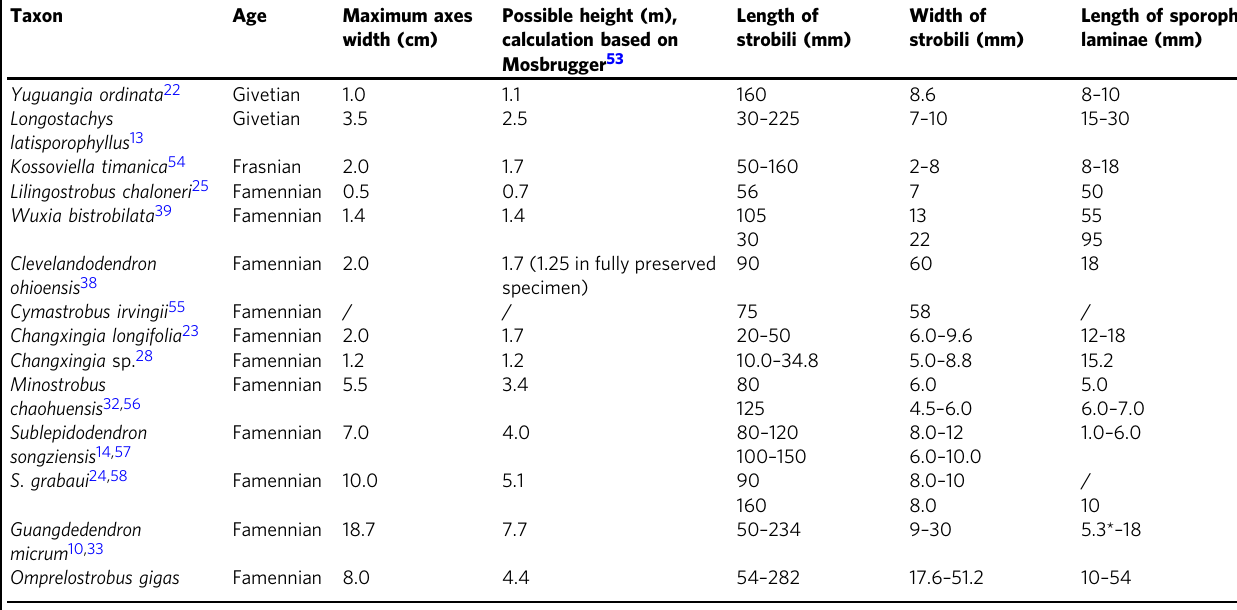
Table 1 The dimensions of some representative Devonian lycopsids and their fertile structures. Taxon Age Maximum axes Possible height (m), width (cm) calculation based